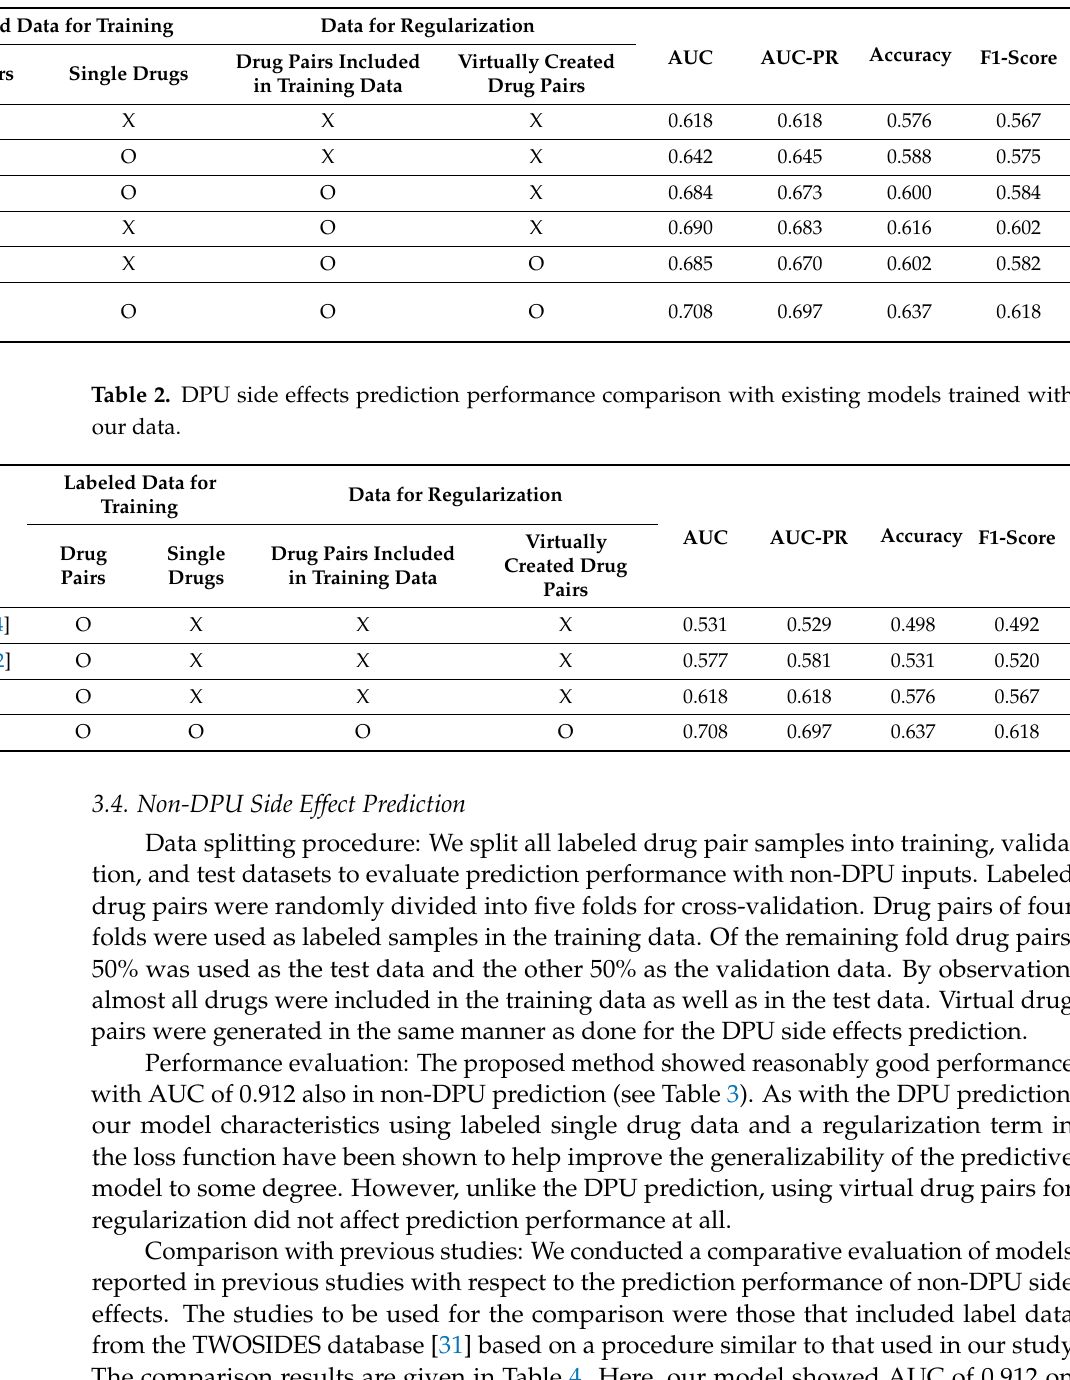
Table 1. DPU side effects prediction performance for the 200 targeted side effects with respect to model characteristics. The performance is based on AUC (Area under the receiver operating characteristic curve) and AUC-PR (Area under the curve of Precision-Recall) averaged over 200 side effects. The hyperparameter A was set to 0.7 at which our model showed highest performance in predicting DPU side effects.